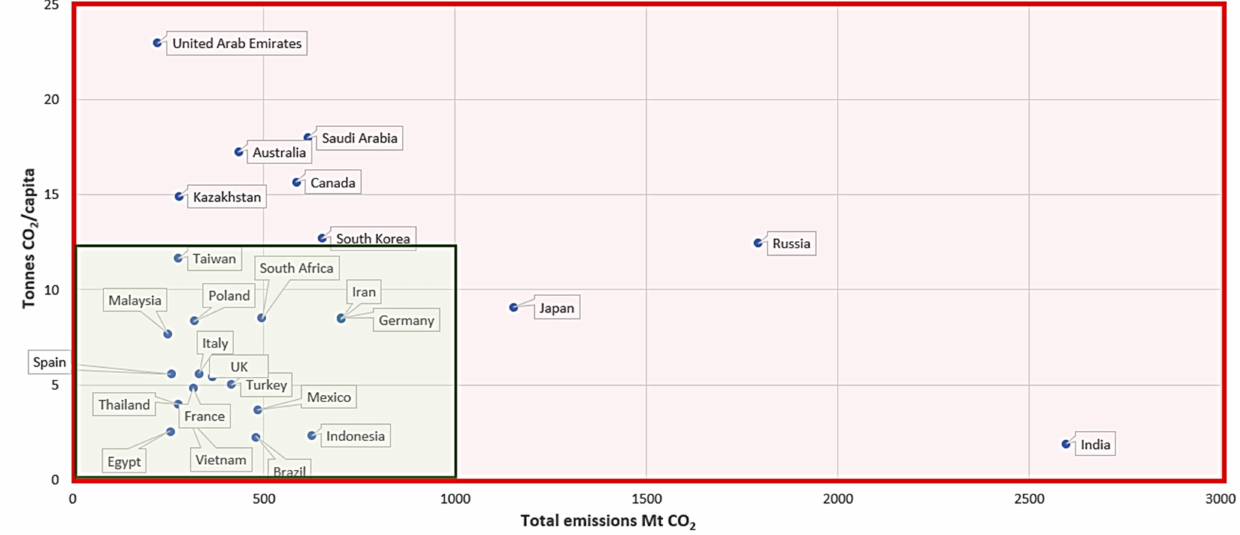
Figure 2. Traffic light diagram of the total emissions vs. emissions per capita. Own